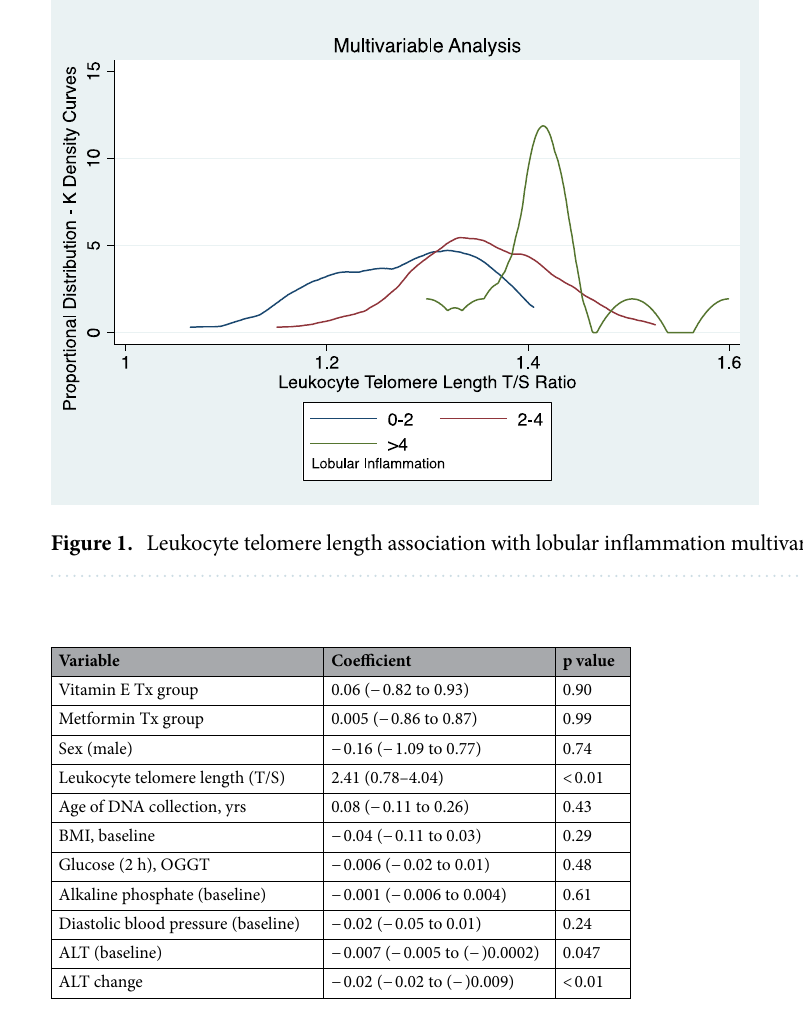
Table 6. Predictors of Lobular Inflammation Worsening at 96 Weeks (n =